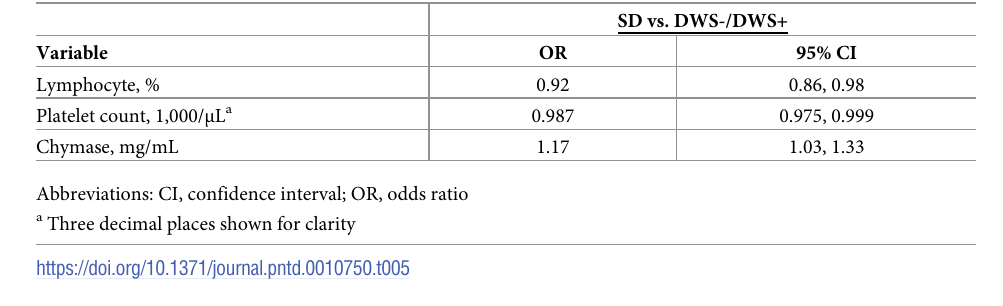
Table 5. Binomial logistic regression model of laboratory results and disease severity.